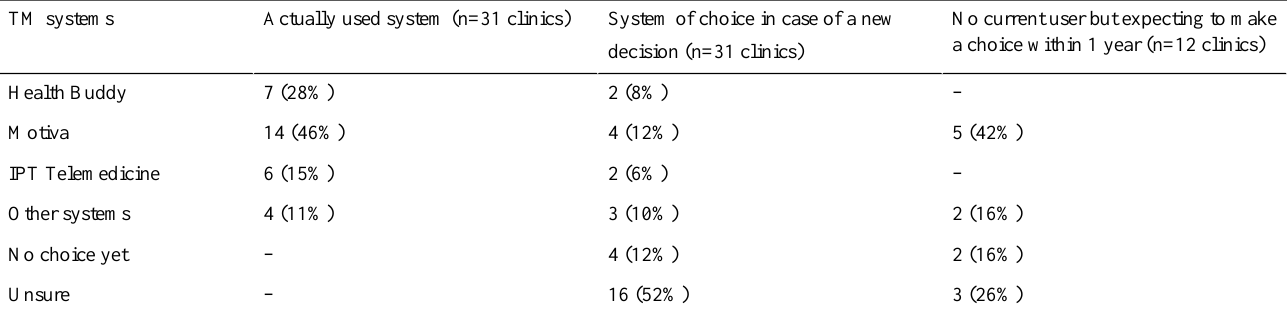
Table 2. Availability and use of telemonitoring (TM) system by actual users (n=31) and planned users